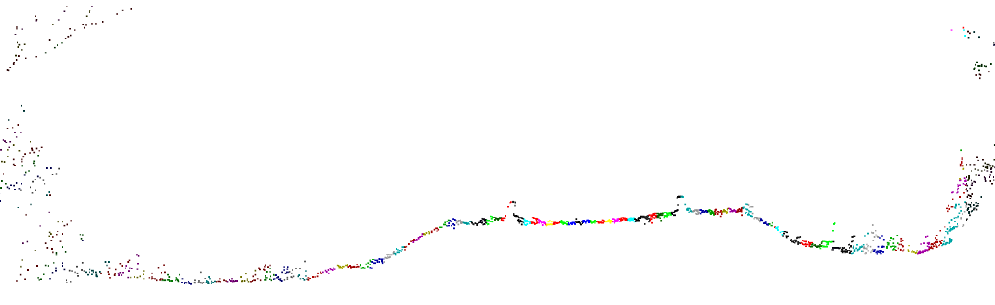
Figure 3. Scan angle coloured point cloud from a cross-section.